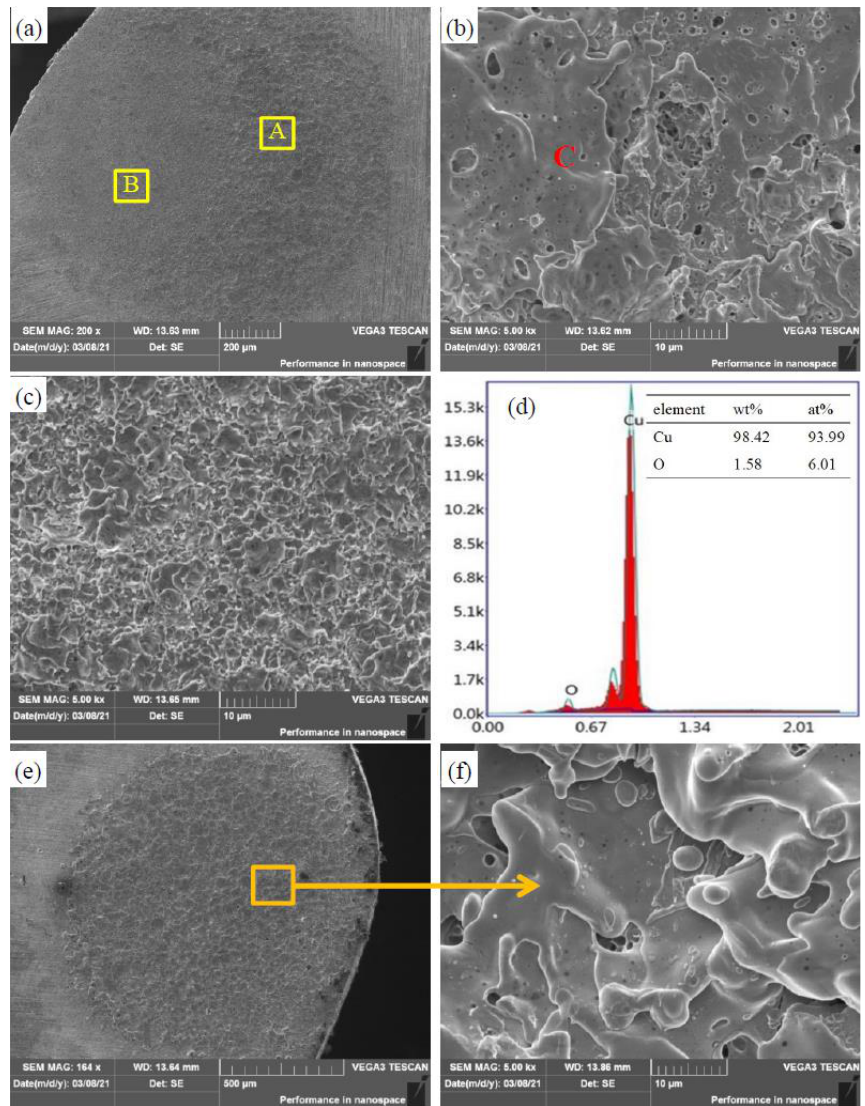
Figure 12. Surface observation and analysis of pure Cu contacts after electric contact test: ( a ) anode contact; ( b ) enlarged view of area A in ( a ); ( c ) enlarged view of area B in ( a ); ( d ) EDS of area C in ( b ); ( e ) cathode contact; ( f ) larger version of ( e ).